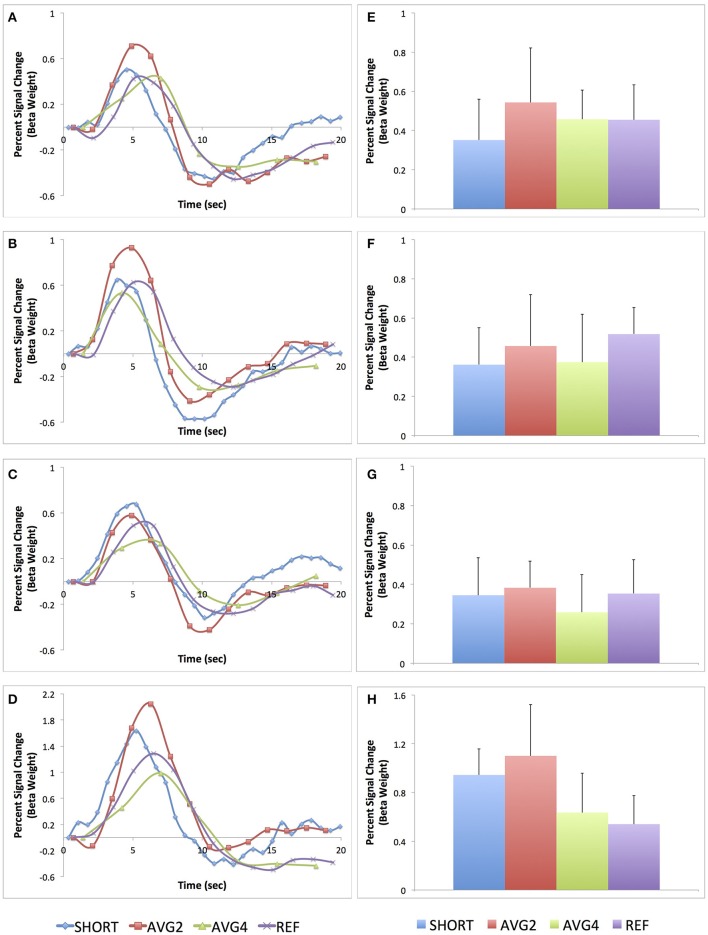
Peri-stimulus histogram timing curves and average percent signal change for each of the four EPI sequences for four task-related regions-of-interest. (A) PSTH curve for anterior cingulate cortex; (B) PSTH curve for supplementary motor area; (C) PSTH curve for left primary motor cortex; (D) PSTH curve for medial primary visual cortex; (E) Average percent signal change for anterior cingulate cortex; (F) Average percent signal change for supplementary motor area; (G) Average percent signal change for left primary motor cortex; (H) Average percent signal change for medial primary visual cortex. Both the curves and average percent signal change values are plotted in terms of percent signal change of the beta weight. Data from the SHORT sequence (TR = 700 ms) are plotted in blue, AVG2 sequence (TReffective = 1400 ms) in red, AVG4 sequence (TReffective = 2800 ms) in green, and REF sequence (TR = 1400 ms) in purple.